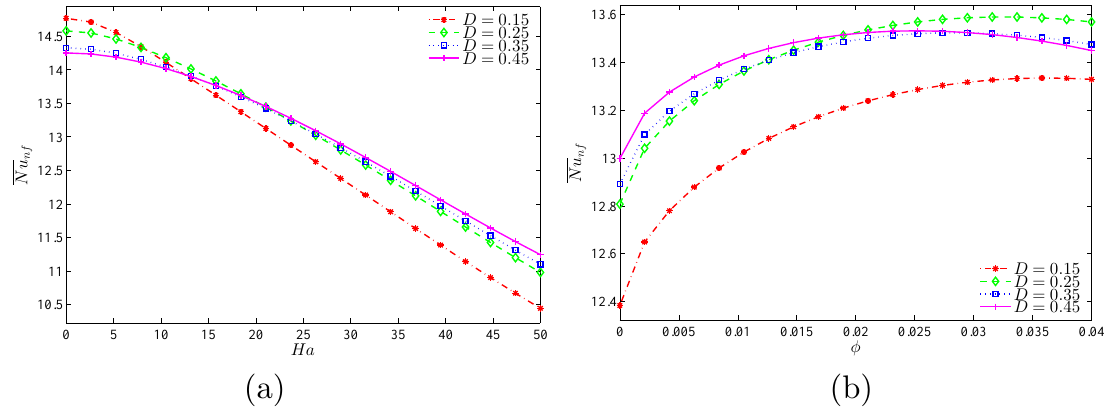
Figure 15. Variation in the average Nusselt number with ( a ) Ha and ( b ) φ for different D at Ri =